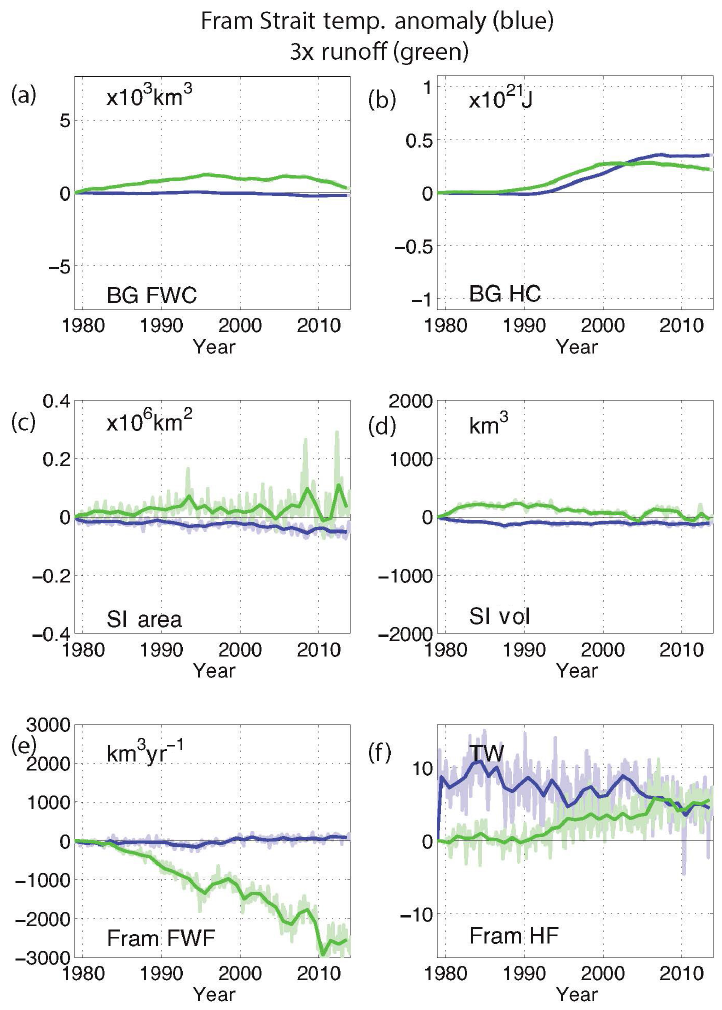
Figure 8. CRFs in response to an impulsive 3 × Runoff (green lines) and Fram Strait T ( + 2 C) anomaly (blue lines): (a) the FWC of the BG (b) HC of the BG (c) SI area (d) SI volume (e) FWF through the Fram Strait, and (f) the HF through the Fram Strait. Note that the units of the y axis appear in the top-left-hand corner of each